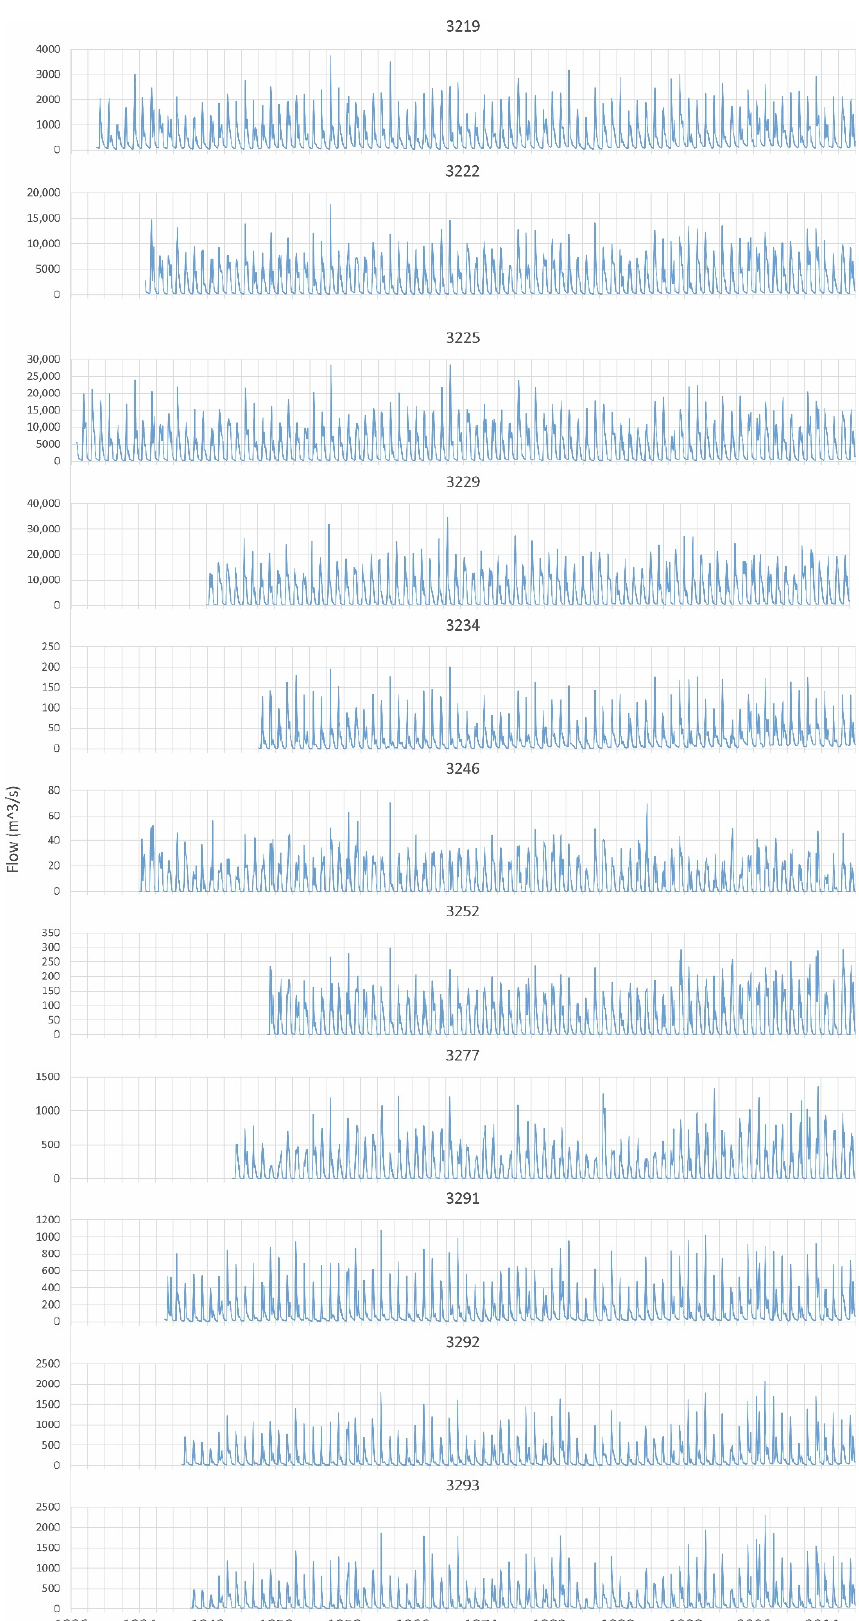
Figure 2. Monthly discharge series of the 11 studied gauges (m 3